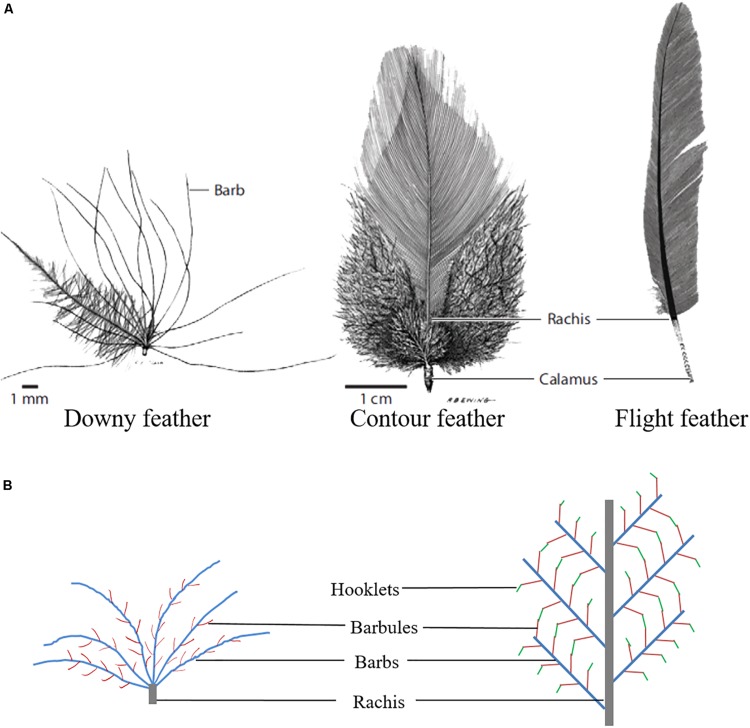
Feather branching morphogenesis. (A) Different types of chicken feathers (Lucas and Stettenheim, 1972). (B) Feather branching structure.